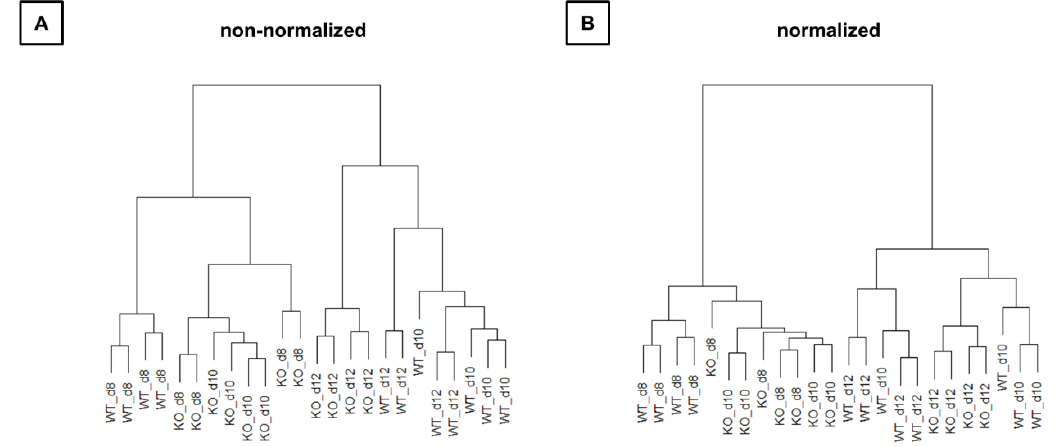
Figure 5. Relation of all samples to each other in hierarchical cluster trees. ( A ) Raw next-generation sequencing (NGS) data are used for representing. ( B ) NGS data are normalized. KO: knockout, WT: wild type d8: 8-day-old, d10: 10-day-old, d12: 12-day-old.